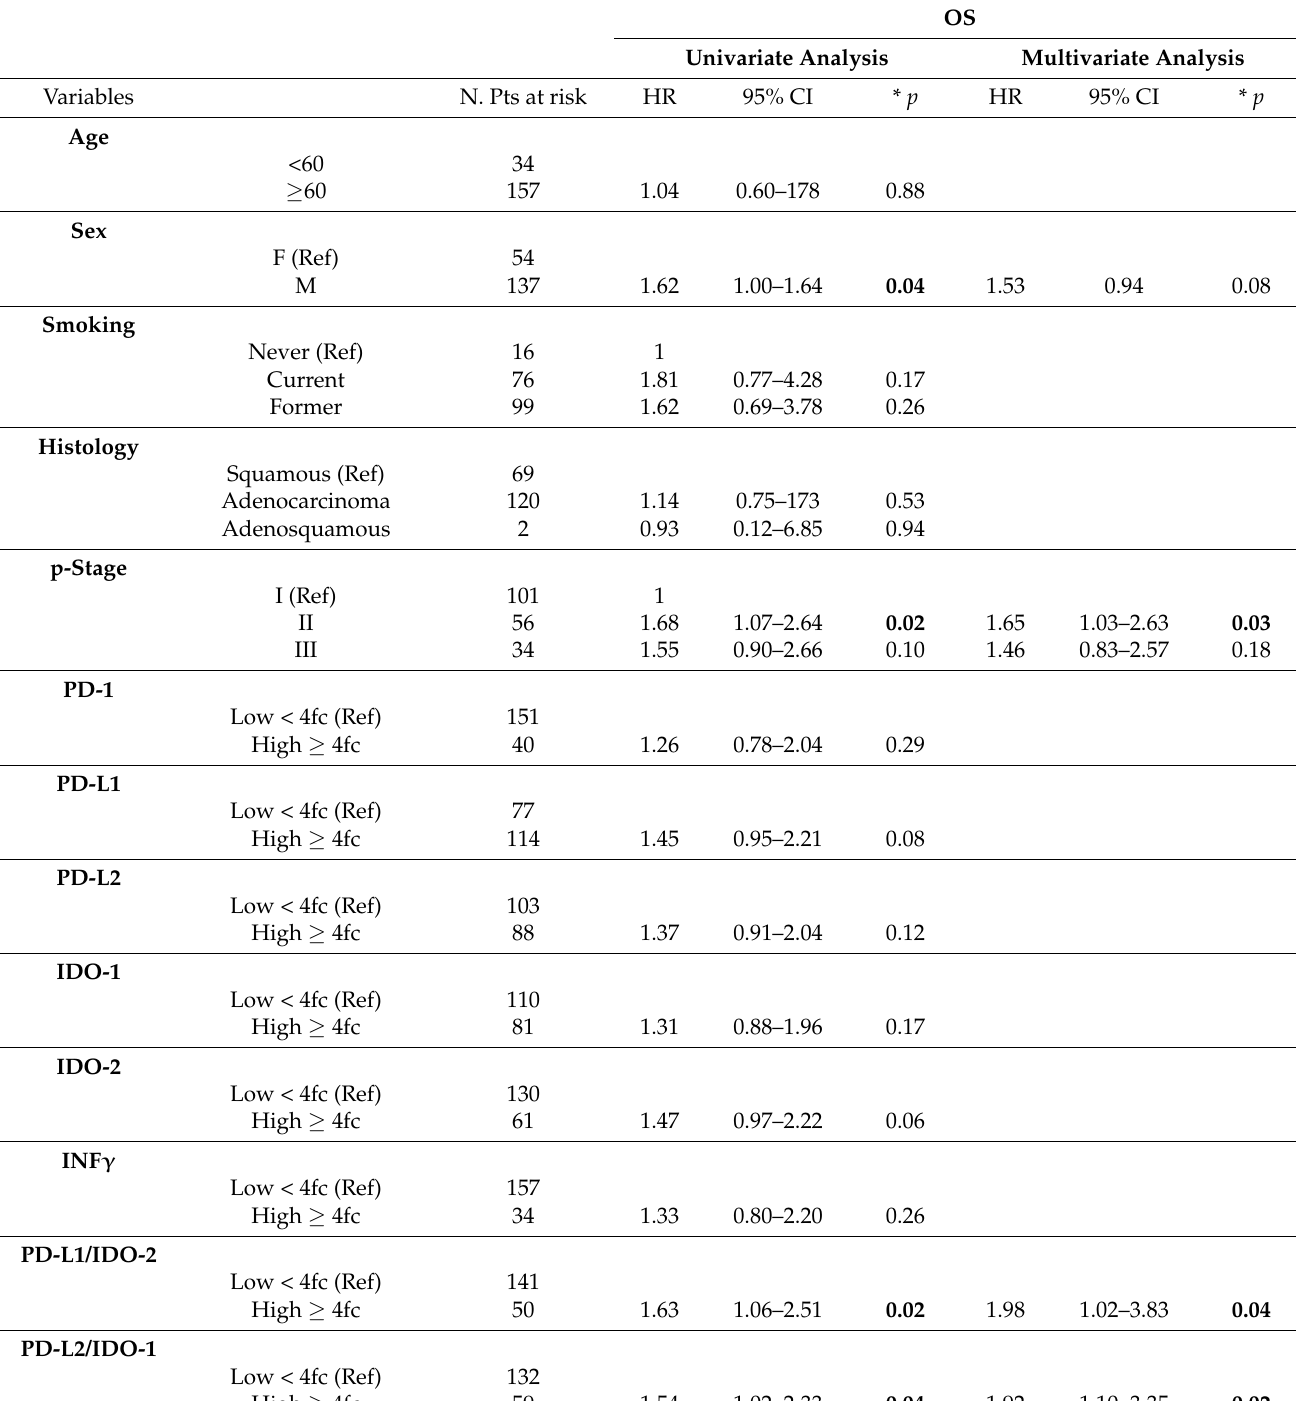
OS Univariate Analysis Multivariate Analysis